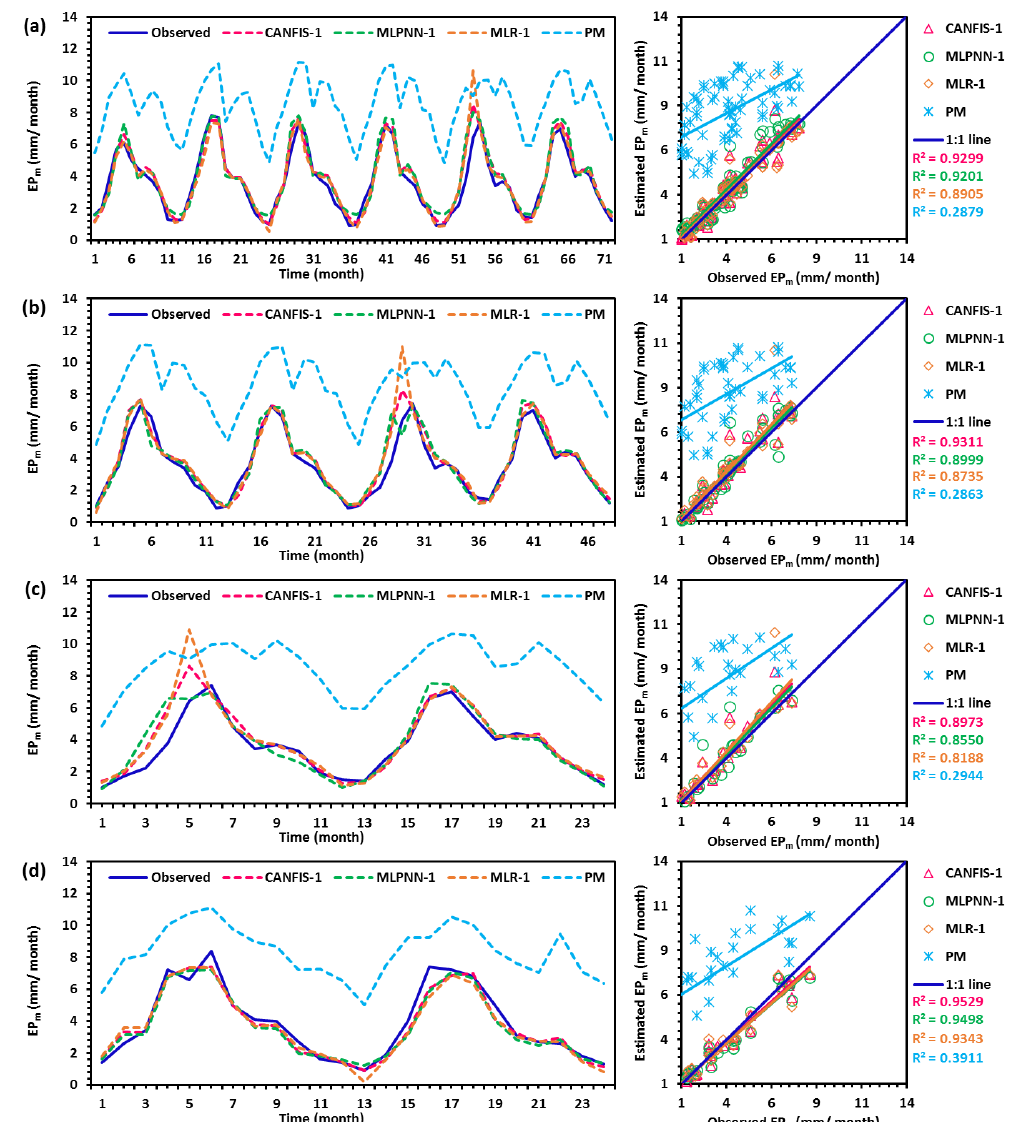
Figure 10. Comparison plots of observed and estimated monthly pan-evaporation values yielded by the CANFIS-1, MLPNN-1, and MLR-1 models in ( a ) scenario-1, ( b ) scenario-2, ( c ) scenario-3, and ( d ) scenario-4 during the testing period at Nagina station.